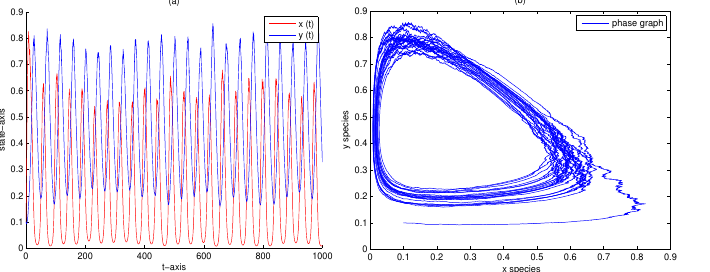
Figure 10. The equilibrium status E ∗ ( x ∗ , y ∗ ) of (4) with σ 1 = σ 2 = 0.5 is numerically unstable: ( a ) time-series curves of x ( t ) and y ( t ) and ( b ) phase diagram. We summarize the simulation results in Table 3. Table 3. Numerical simulations of (4) with parameters given in (10). Parameters Stability of